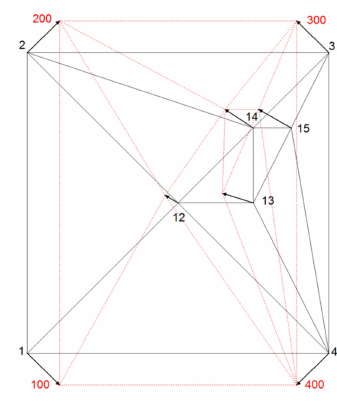
Figure 6. Faults of the inverse distance weighted (IDW) method presented with irregular point shifts and triangles